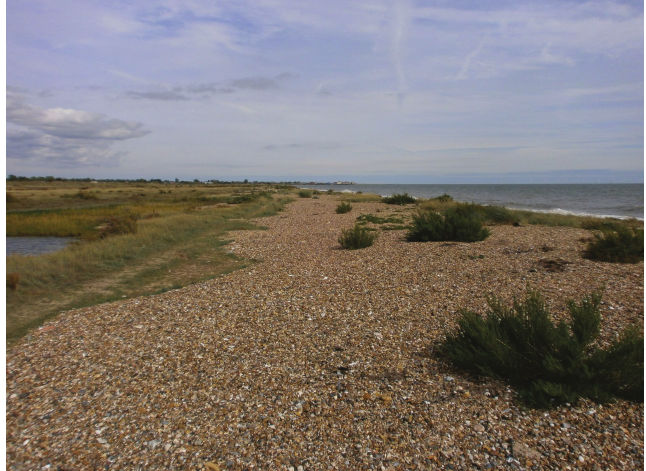
Fig. 1. Shingle deposition on the fore dunes. Photo credit Tim Gardiner.